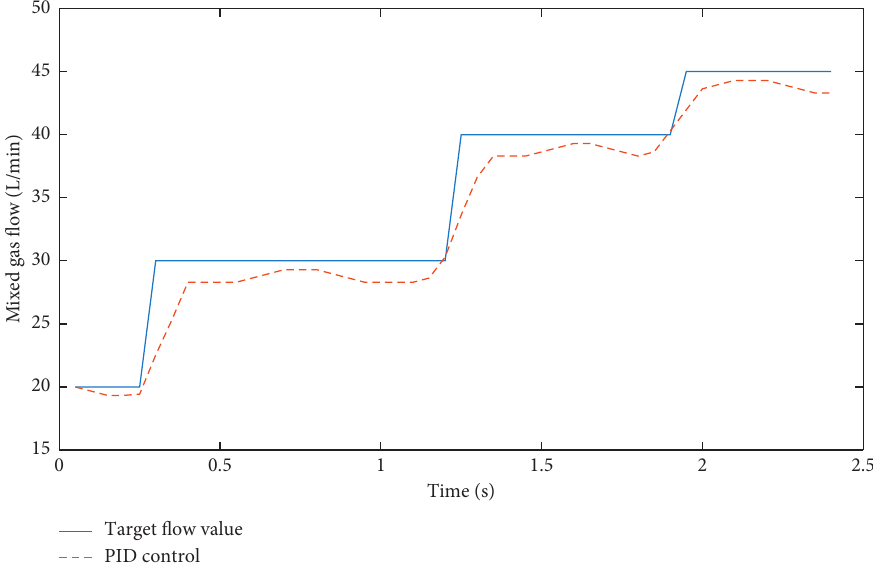
Figure 10: Comparison of total flow of mixed gas continuously regulated by PID